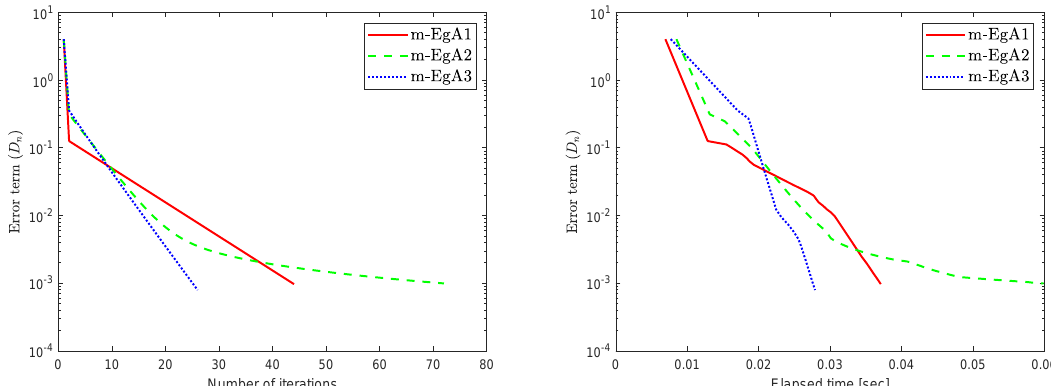
Figure 10. Numerical behaviour of Algorithm 1 compared to Algorithm 1 in [30] and Algorithm 2 in [30] for Example 1, when u 0 = sin ( t ) .